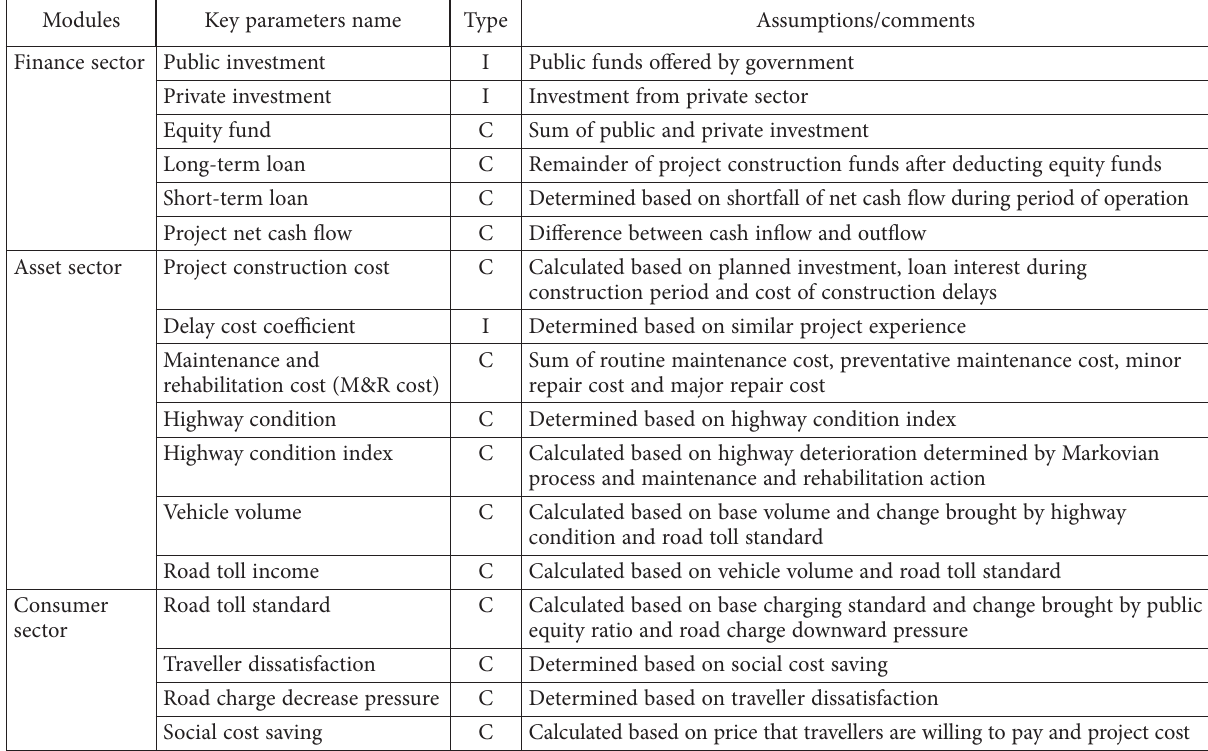
Table 1. Key strategic parameters of the system dynamic model